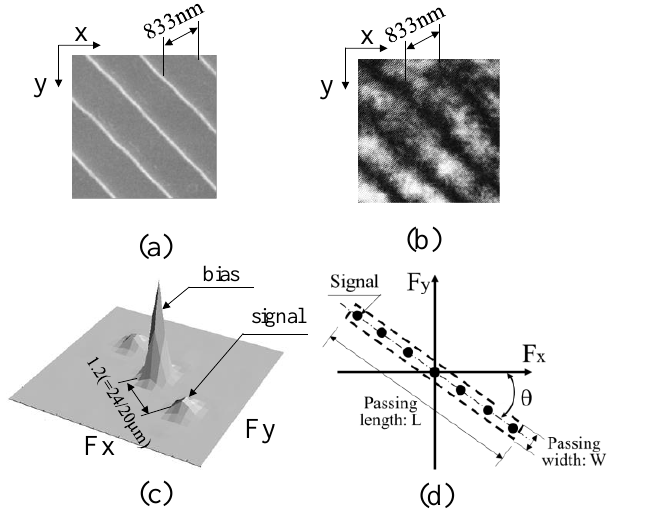
Figure 6. Two-dimensional analysis. ( a ) Measured object; ( b ) Specklegram in spatial domain; ( c ) Specklegram in frequency domain; ( d ) Passband of two-dimensional filter.